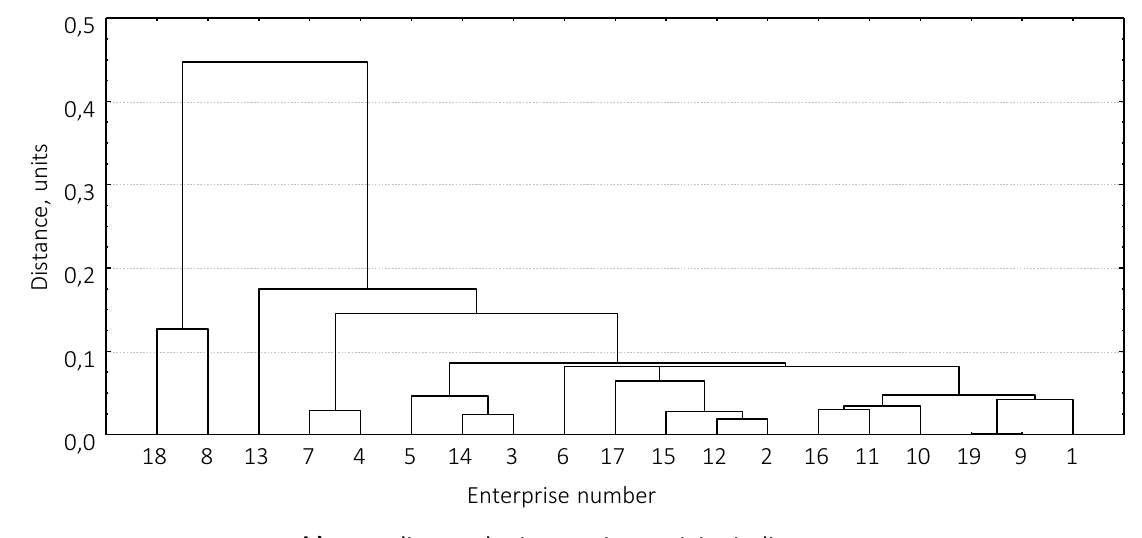
b) according to the innovation activity Figure 2. The dendrogram constructed based on investment and innovation activity indicators